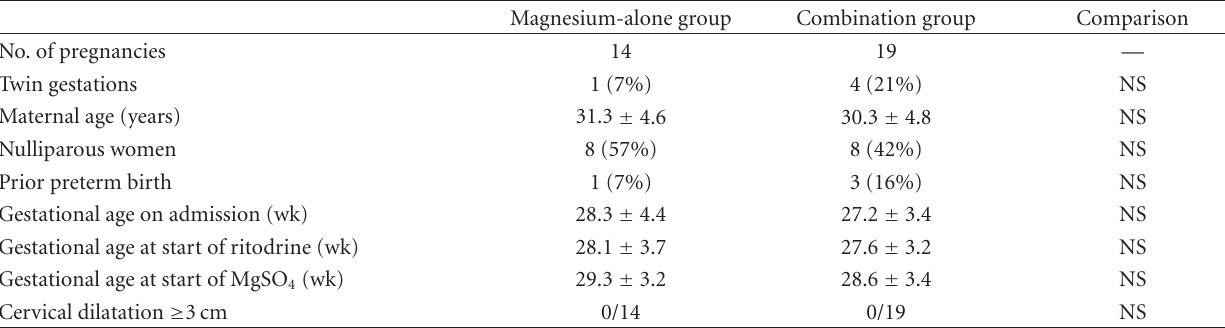
Table 1: Maternal demographic and clinical characteristics at